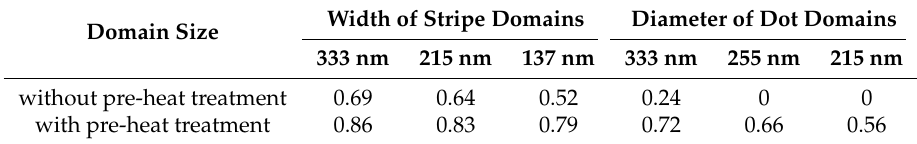
Table 1. The thermal stability parameter, P, of nano-domains in samples with or without pre-heat treatment. The condition of pre-heat treatment was T p = 150 ◦ C for 2 hours. The length of the stripe domains was set to be ∼ 4 µ